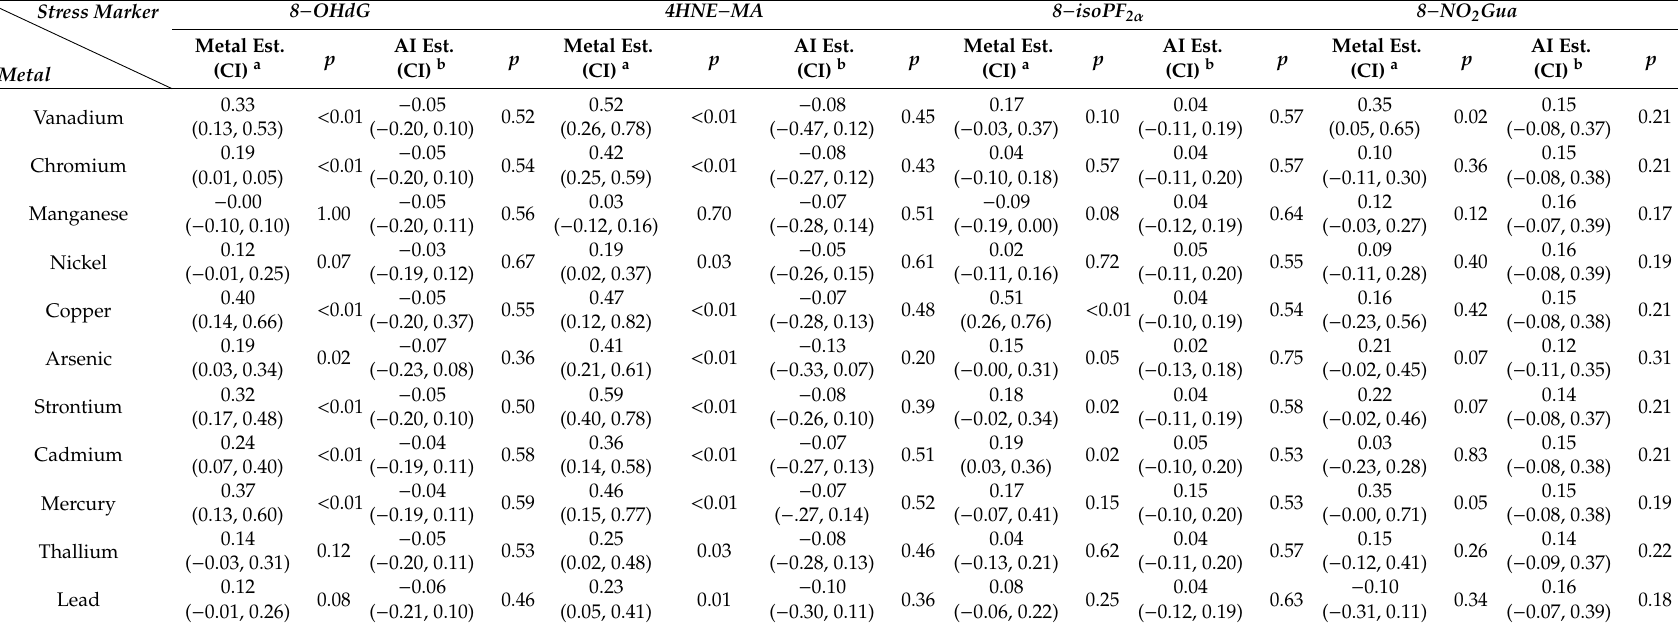
Table 3. The associations between heavy metal exposure and oxidative stress with the antioxidant intake for study subjects (n =